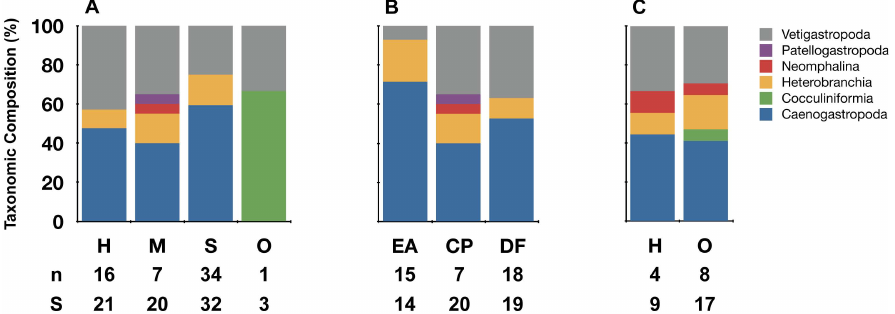
Fig. 4. Taxonomic composition of gastropod assemblages in the Gulf of Cadiz. (A) Comparison between different substrate types (samples from mud volcano and adjacent habitats). (B) Comparison between bathymetric sub-regions (samples from mud volcanoes only). (C) Com- parison between hard and organic artificial substrata from in situ colonization experiments. Figures below bars indicate the number of samples ( n ) and the number of species (S) in each assemblage. H: hard; M: mixed; S: soft; O: organic; EA: El-Arraiche; CP: Carbonate Province; DF: deep